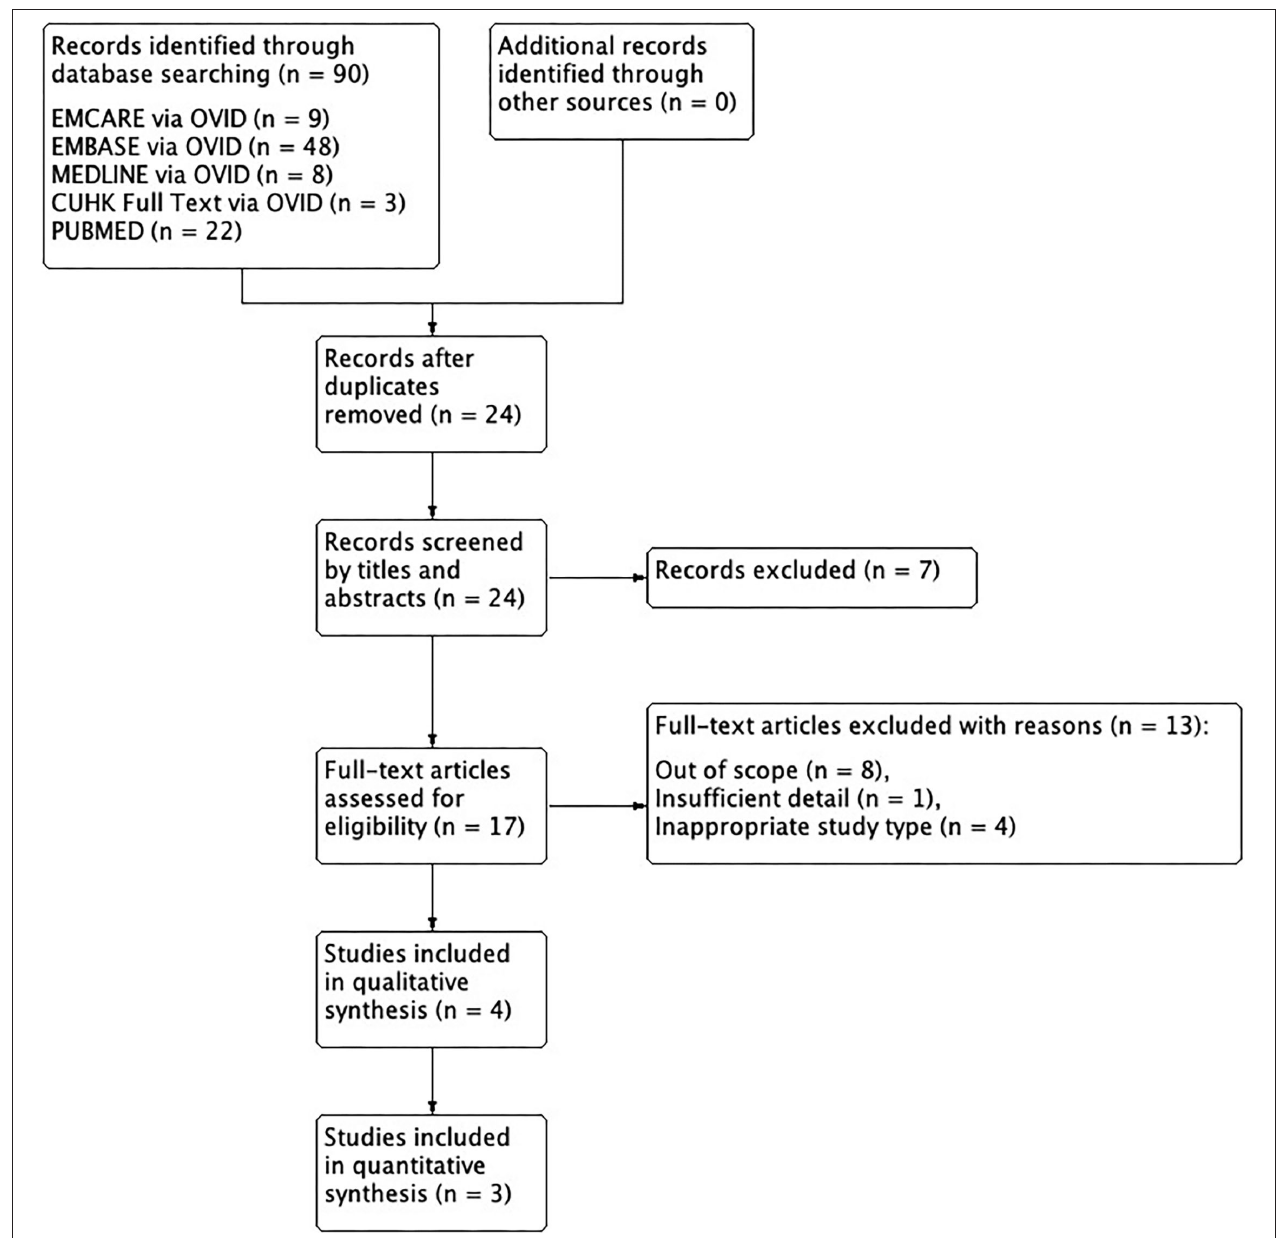
FIGURE 2 | PRISMA flow diagram on